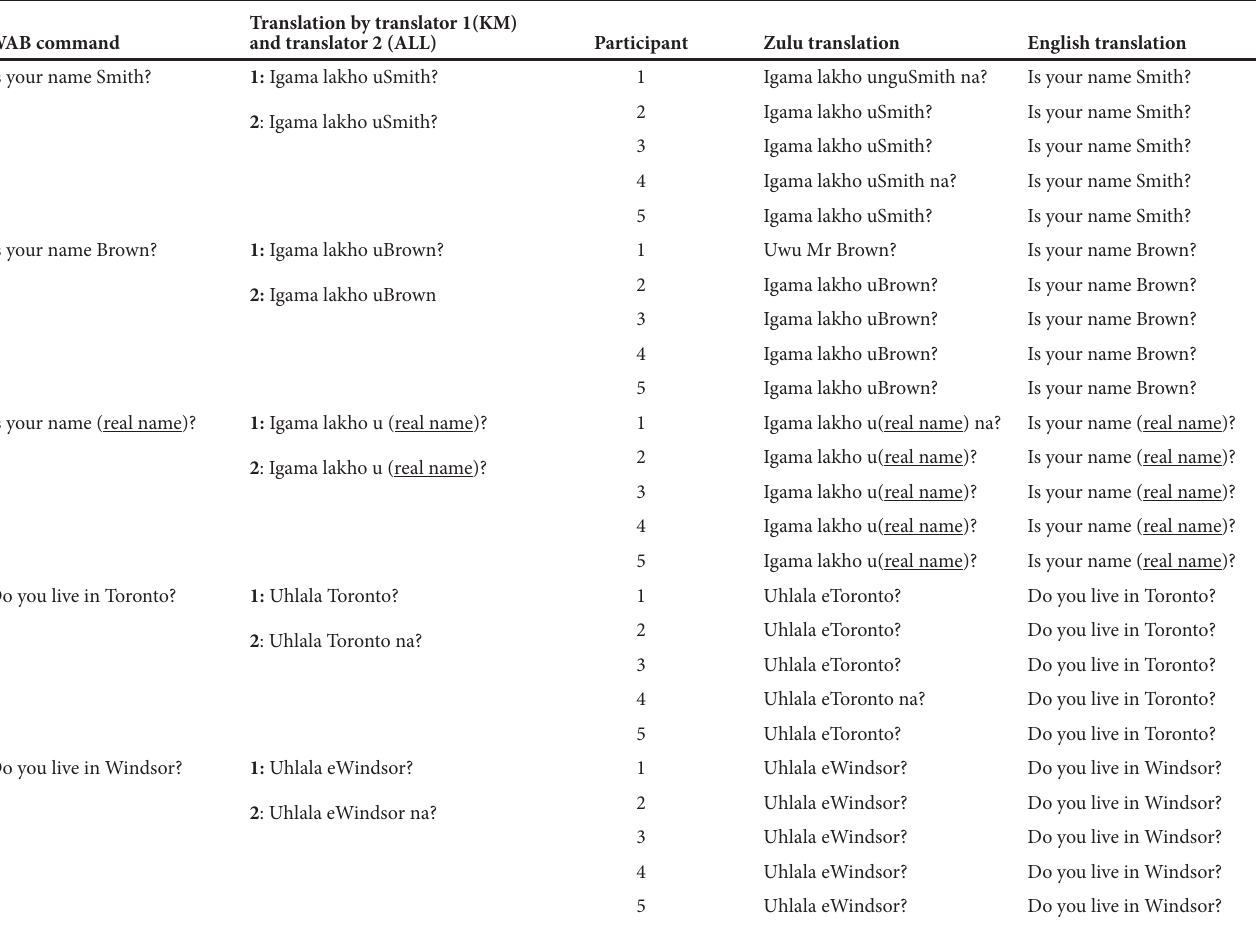
Table 2. Translation of the auditory verbal comprehension subtest of the